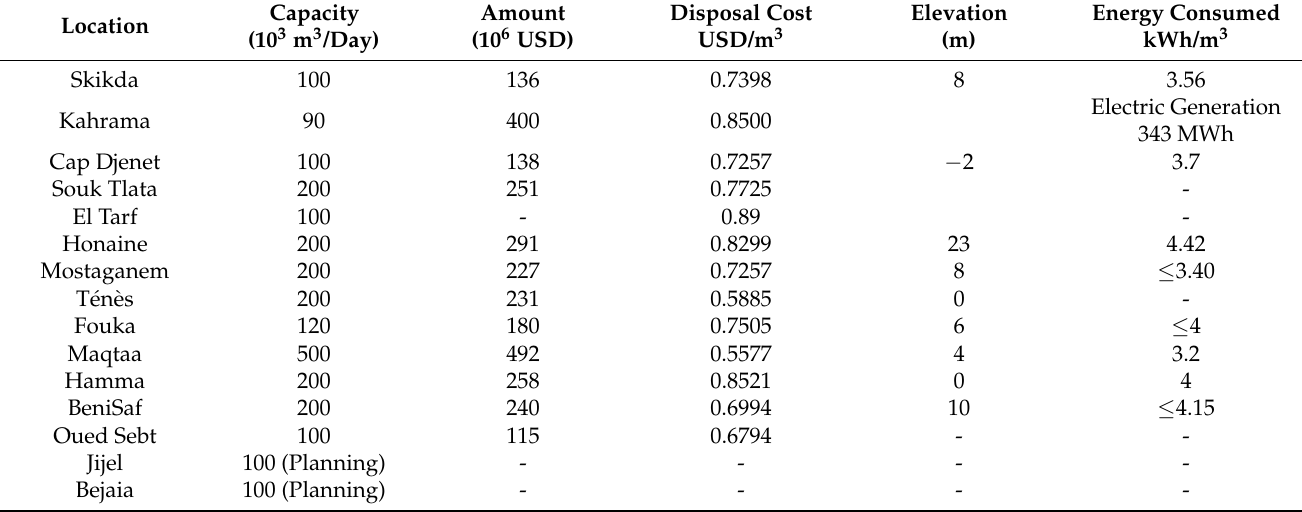
Table 6. Details of the large desalination plants installed during the